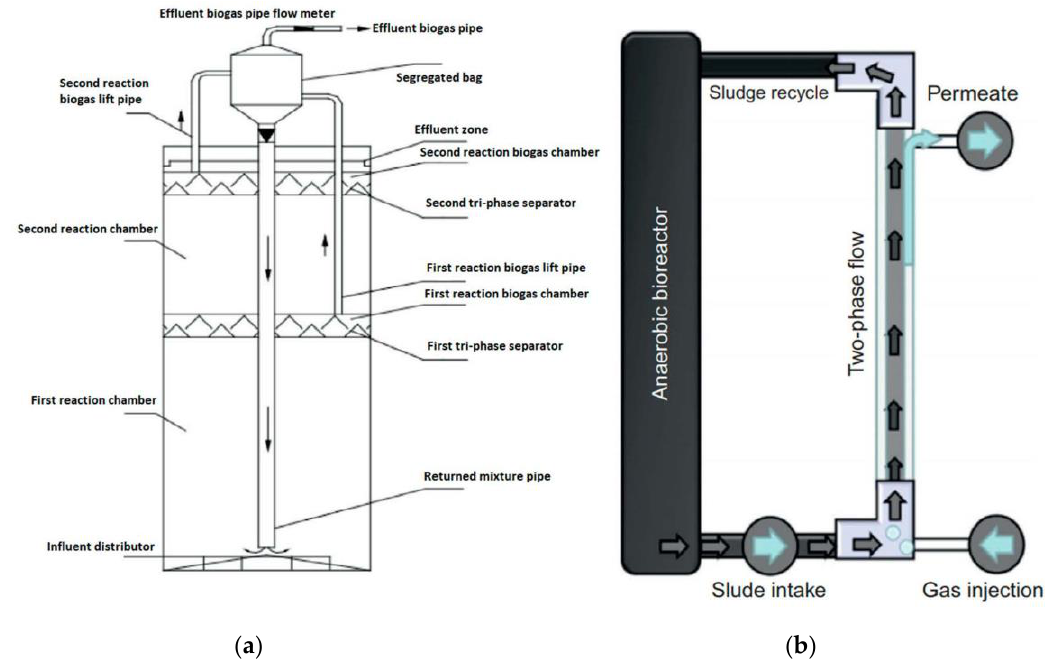
Figure 5. Two novel configurations ( a , b ) of airlifting bioreactor agitating sludge without having an installed mixer—reproduced with permission from the original authors [175,176]. ( a ) biogas-lift reactor (BLR): right upward arrow- first biogas lift included with sludge and water; middle downward arrow — flow of sludge and water; left upward arrow — second biogas lift with separation of sludge and water. ( b ) gas-lift membrane bioreactor: the flow directions of materials are indicated with the arrows and texts in the body of the figure.